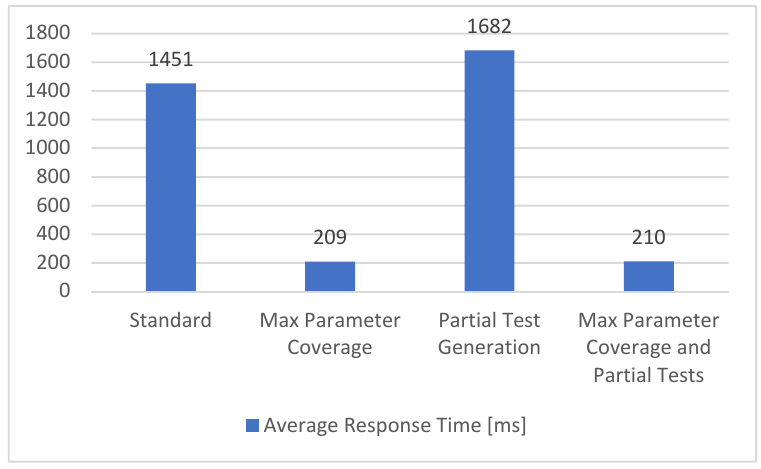
Figure 15. Performance metric.